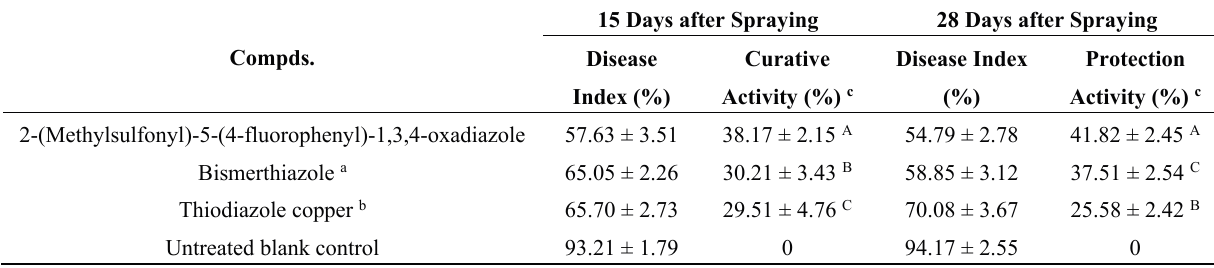
Table 2. Control efficiency of the testing compounds against rice bacterial leaf blight under greenhouse conditions at the concentration of 200 μ g/mL. Compds.